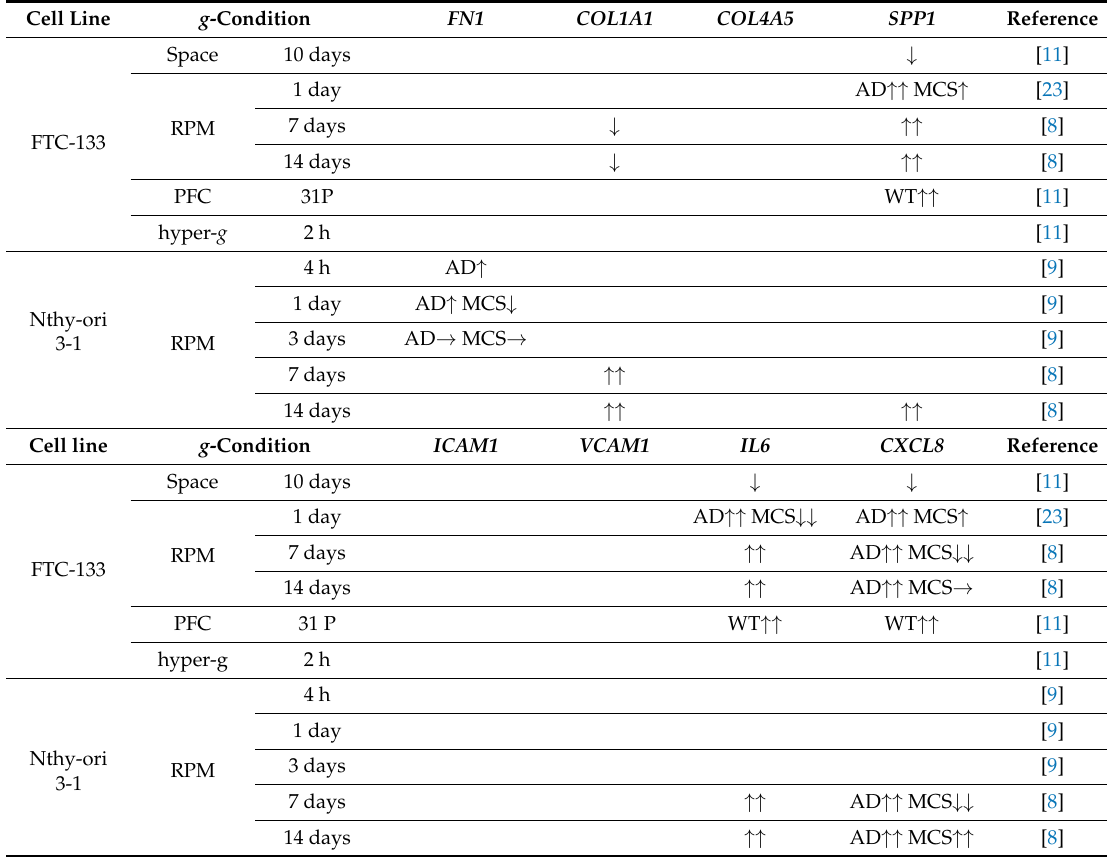
Table 1. Summary of previously found regulations in selected molecular targets due to gravitational alterations. ↑ indicates upregulation; ↓ indicates downregulation; double arrow indicates significant alterations; → indicates no regulation, blank was not